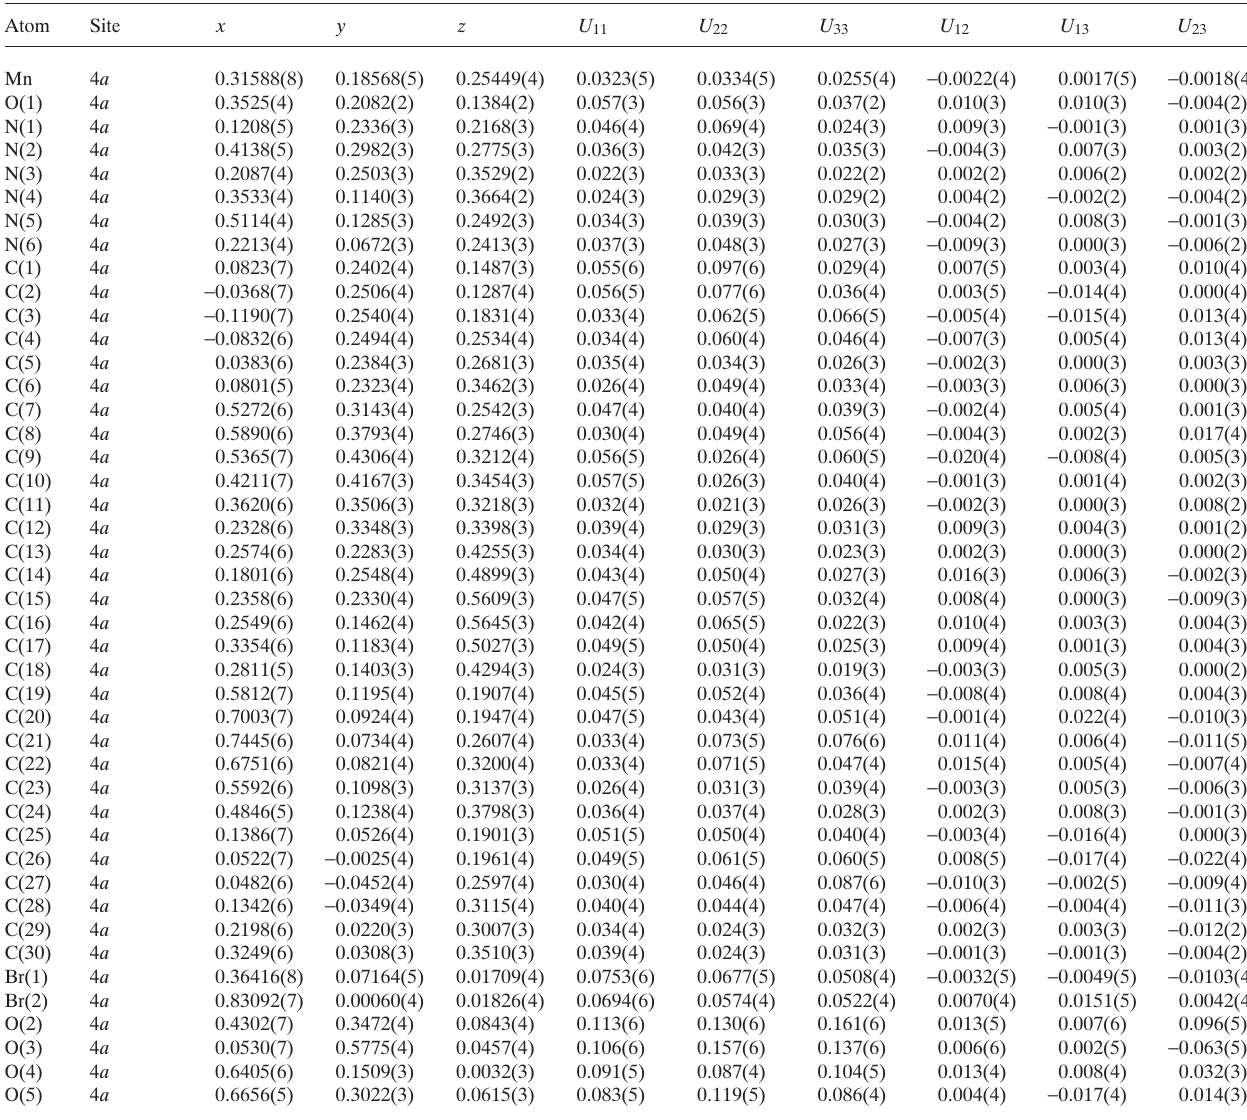
Table 3. Atomic coordinates and displacement parameters (in Å 2 )